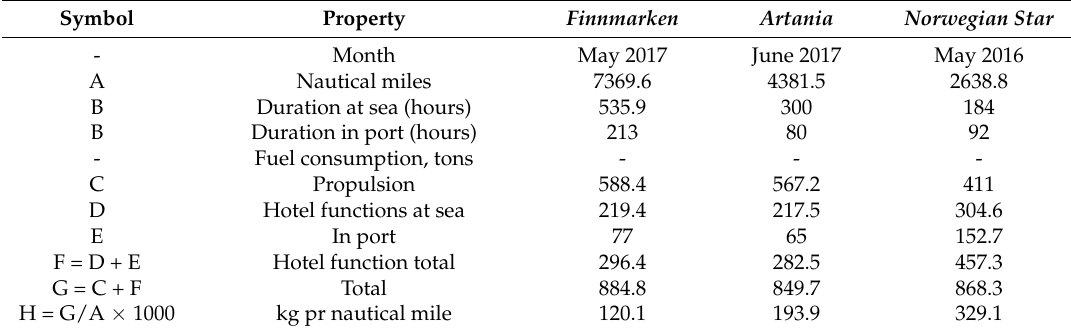
Table 9. Estimates for validation period using IMO formula for load and specific fuel